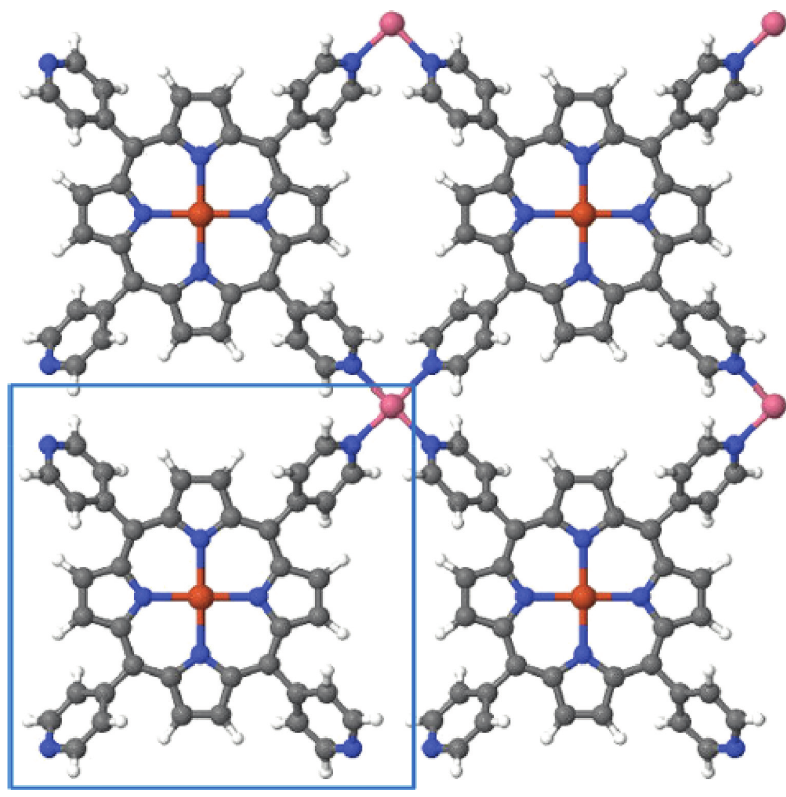
Table 1: The partition of edge set of graph G , d ) where xy ∈ E ( G ( c, d ( d x y 1